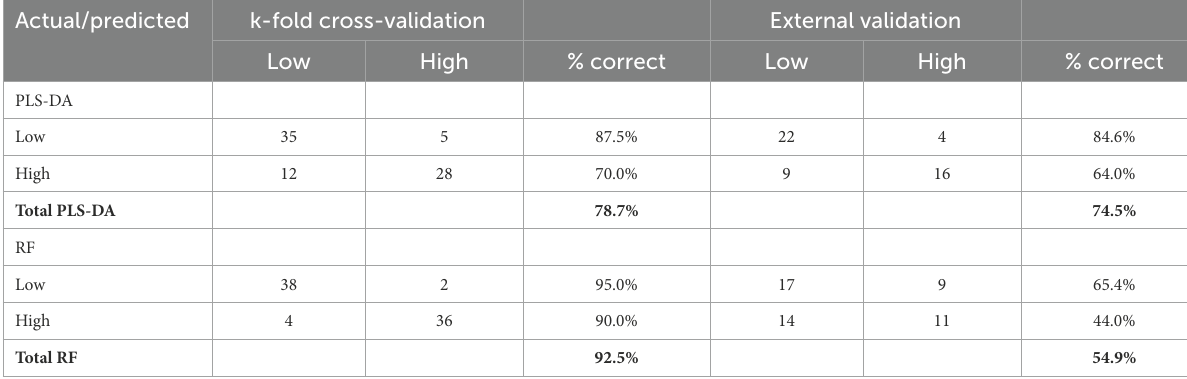
TABLE 2 Identification of Candida albicans strains: k-fold cross-validation and external validation. Actual/predicted k-fold cross-validation External validation Low High %